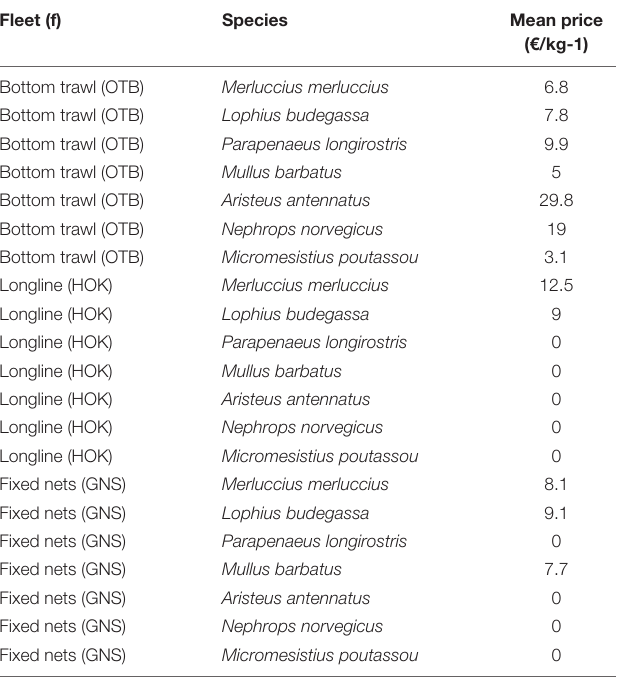
TABLE 5 | Average price of the main species assessed in GSA06, calculated from the 2000–2010 price data series from the Fisheries Directorate of